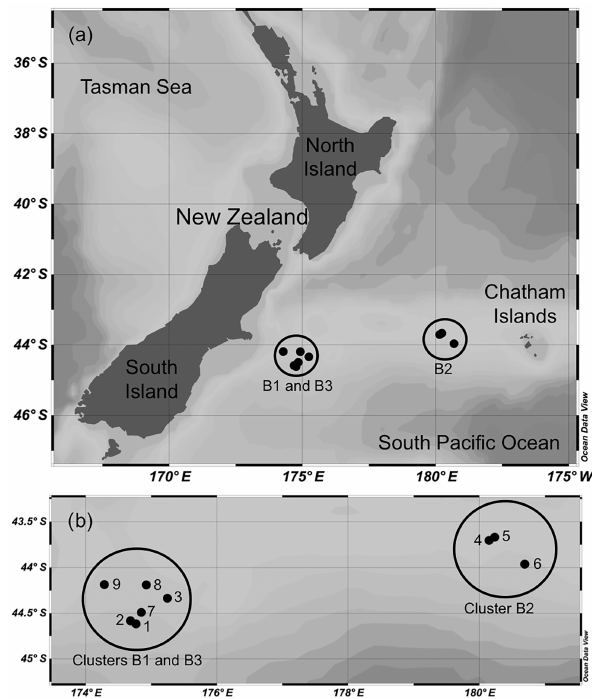
Figure 1. (a) Map of the general sampling area over the Chatham Rise east of New Zealand’s South Island, and (b) close-up of the partitioning of the nine stations in clusters B1, B2, and B3 sampled during the SOAP voyage in February and March